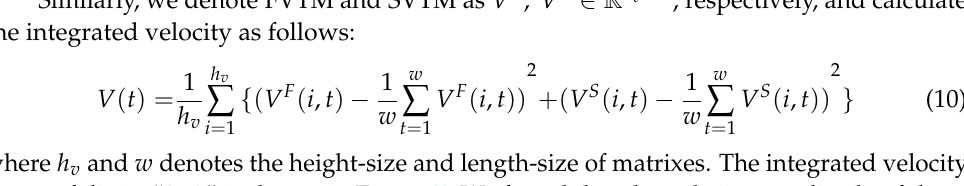
Figure 6. The frontal- and side- trajectories of air writing digits: ( a ) 0; ( b ) 1; ( c ) 2; ( d ) 3; ( e ) 4; ( f ) 5; ( g ) 6; ( h ) 7; ( i ) 8; ( j ) 9.